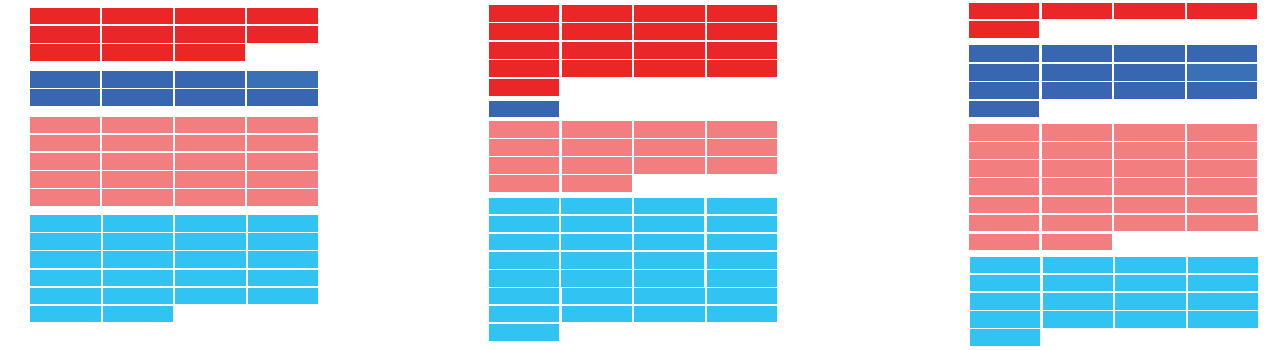
Figure 6. Schematics of preferred codon usage tables for E.coli , P.aeruginosa , and L.lactis following the conventions of Figure 4. Unlike E. coli , P. aeruginosa strongly favors GC3 in high-CAI codons (94%), and L. lactis strongly favors AT3 in high-CAI codons